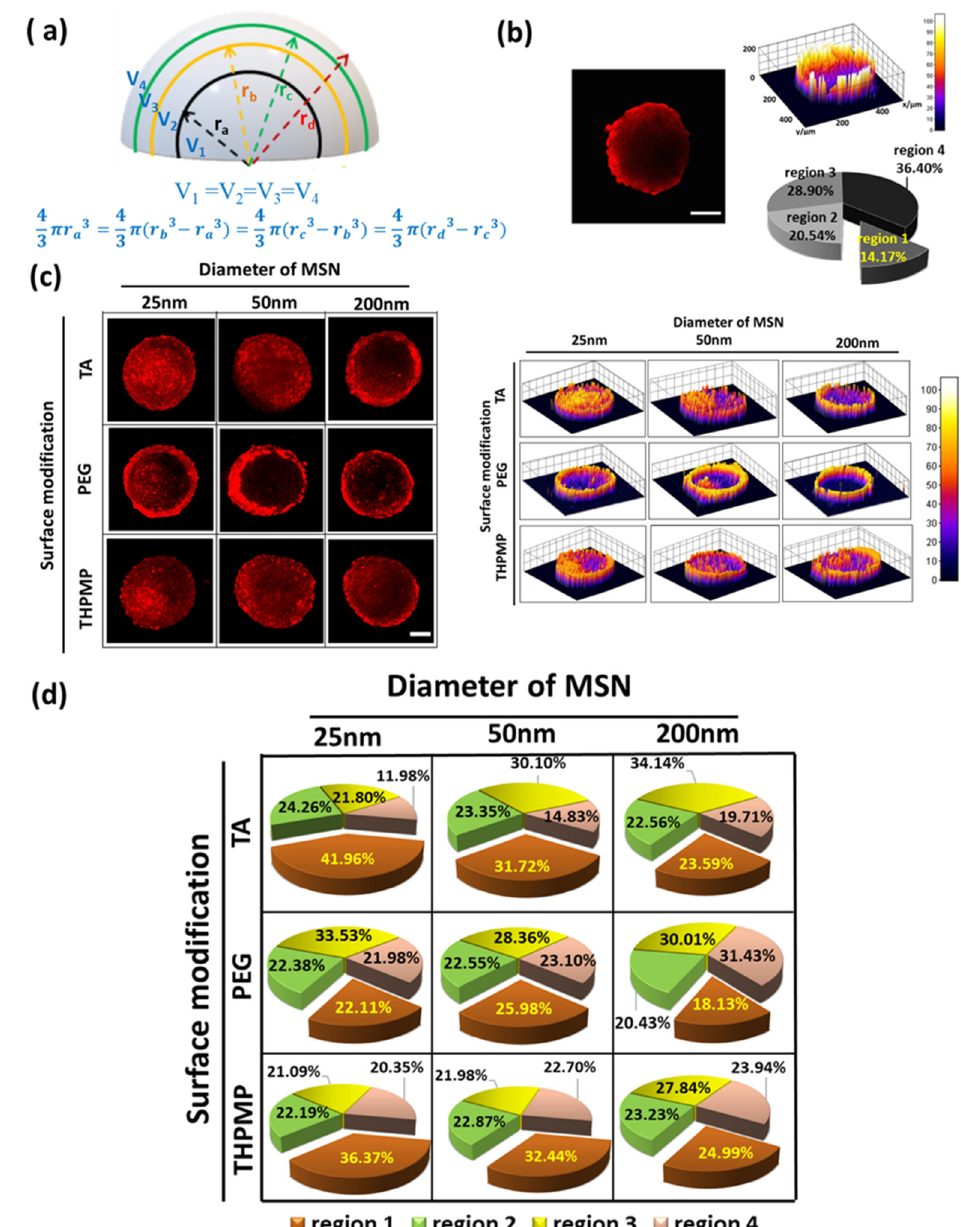
Figure 1. Penetration and distribution of free dye and mesoporous silica nanoparticles (MSNs) in spheroids. ( a ) Illustration of different concentric regions in the spheroid. ( b ) Two-photon image of rhodamine B isothiocyanate (RITC) in spheroid (z = 160 µm) and the distribution of RITC. Scale bars = 100 µm. N = 4. ( c ) Two-photon images of different MSNs in spheroids (z = 160 µm) and the distribution of MSNs. Scale bars = 100 µm. ( d ) Accumulation of MSNs in the different concentric regions. N = 4.